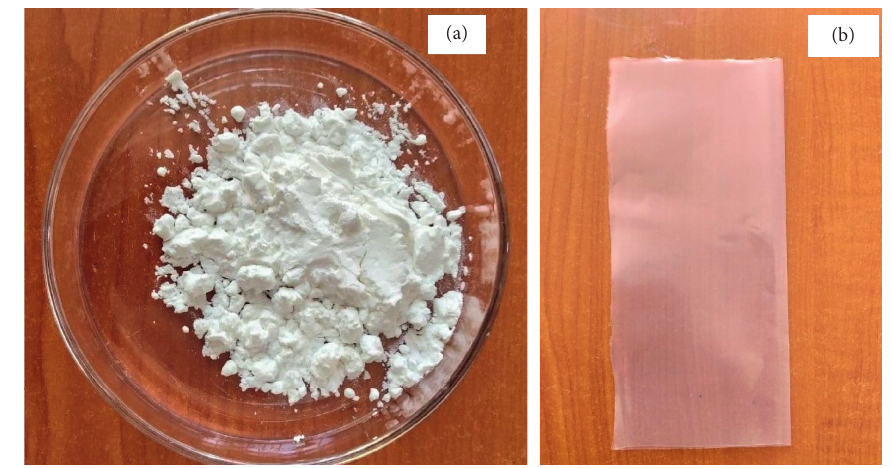
Figure 2: The starch extracted from ASS (a) and the developed edible film prepared from ASS